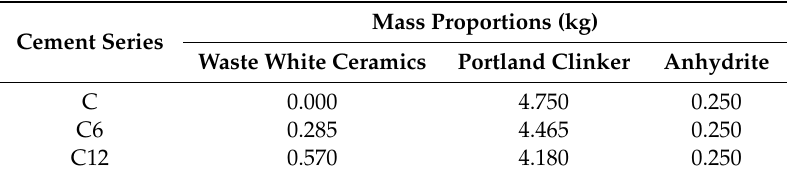
Figure 5. Small ball mill. Table 1. Composition of ball mill charges.